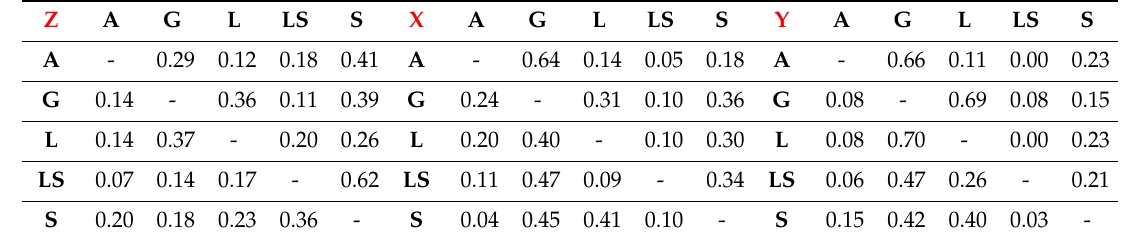
Table 2. Embedded Transition Probabilities (ETP) along the directions Z (depth), X (longitude) and Y